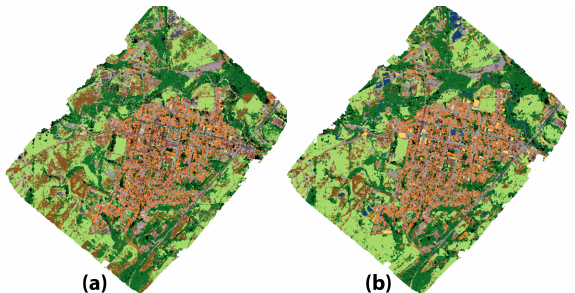
Figure 7. Classified Images Test 1. (a)Step 1 and (b)Step 1+2.